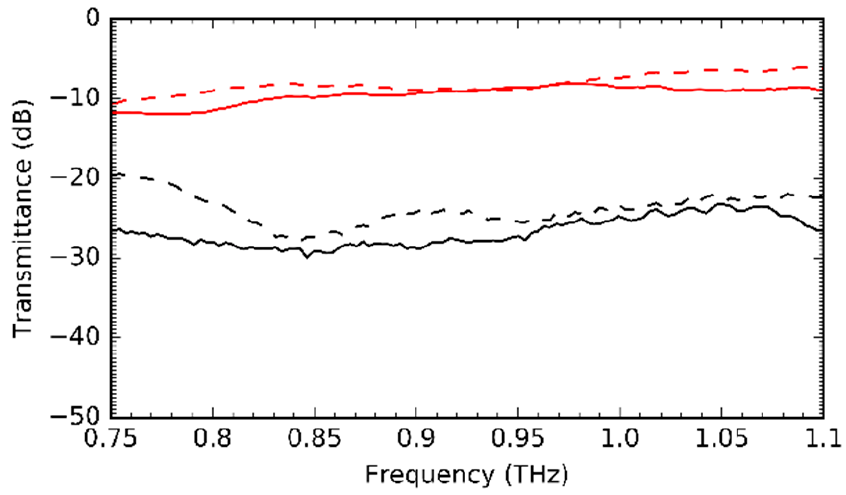
Figure 15. Measured S21 (red) and S31 (black) of proposed Y-branch (dashed lines) and Y-branch module (solid lines).